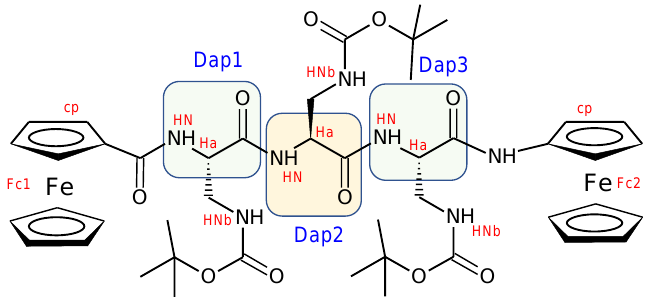
Scheme 2. Functional groups of 3 with labels.